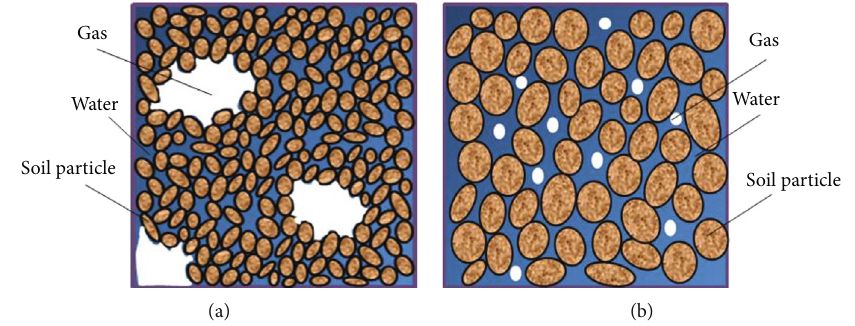
Figure 1: Existence forms of gas bubbles in gassy soil: (a) fi ne-grained soil; (b) coarse-grained